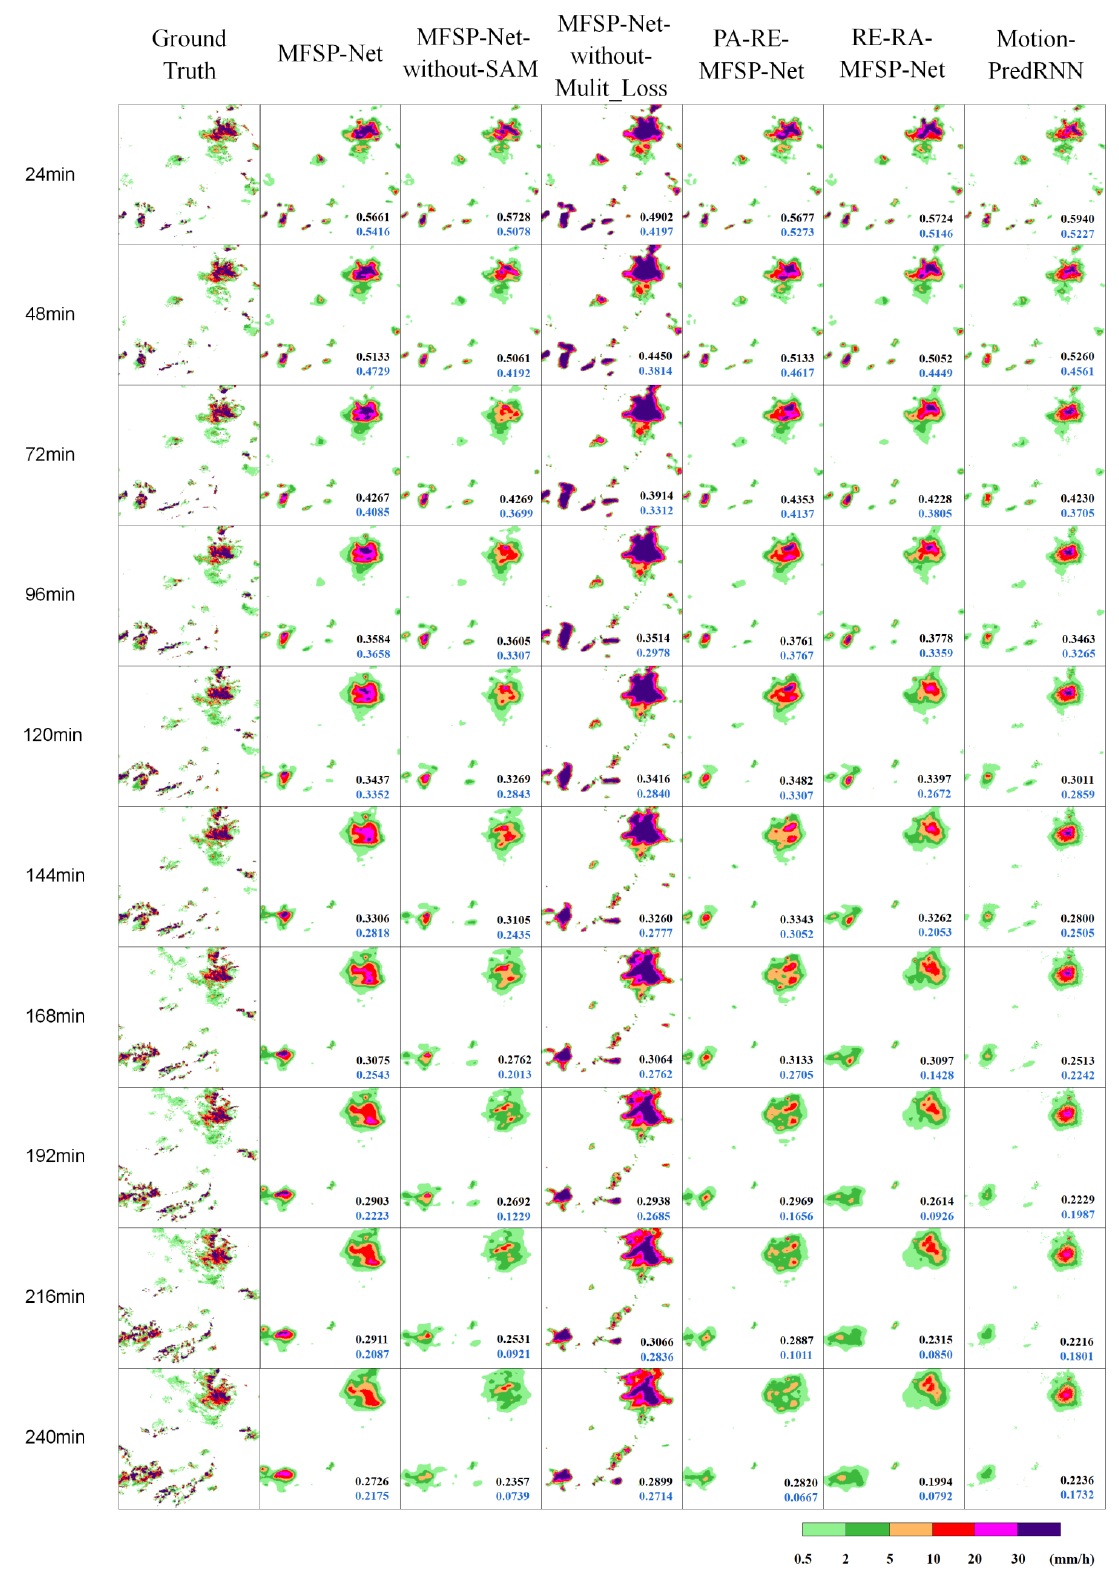
Figure 8. Visualization of one representative precipitation intensity nowcasting case. From left to right are the 10 frames’ truth radar echo data of the next four hours and precipitation intensity nowcasting conducted by MFSP-Net, MFSP-Net- without-SAM, MFSP-Net-without- Multi - Loss , PA-RE-MFSP-Net, RE-RA-MFSP-Net, and Motion-PredRNN. The black value and blue value in each nowcasting frame are the CSI with 2 mm/h and 5 mm/h as the threshold for this